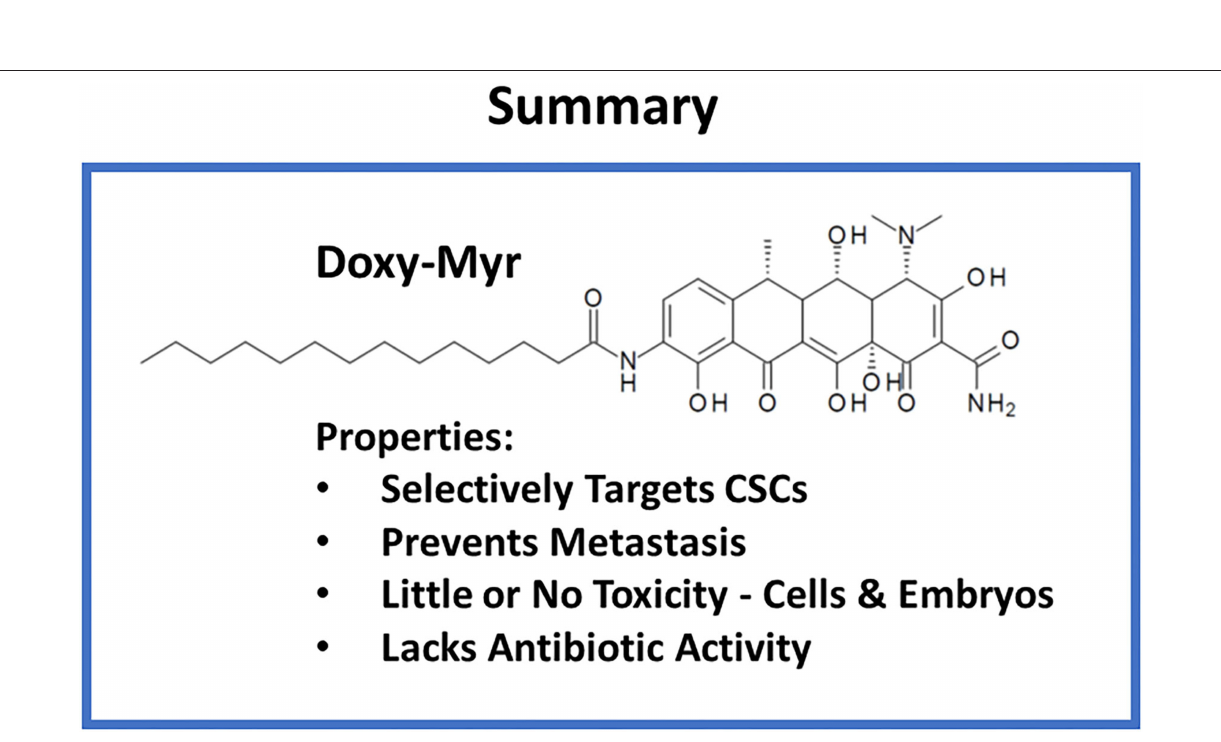
Frontiers in Oncology | www.frontiersin.org